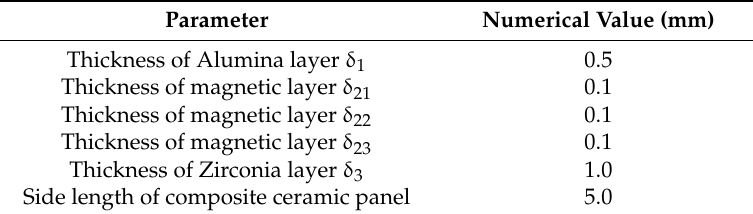
Table 3. Main parameters of the model with a three-layer gradient.